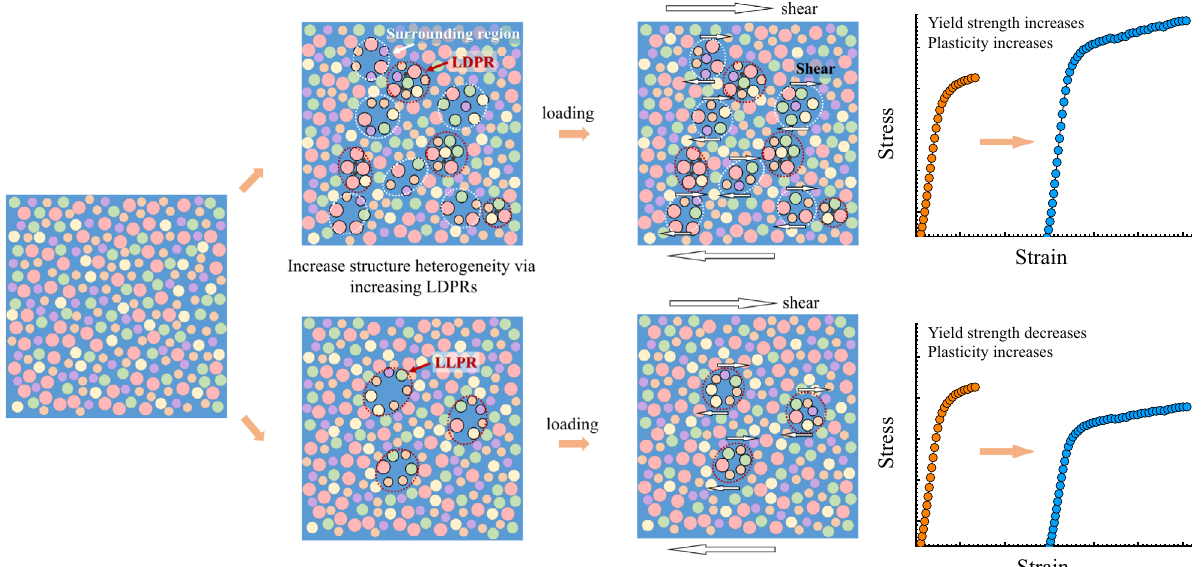
Fig. 6 Schematic illustration of two ways to enhance structural heterogeneity of BMGs. One is to increase LLPRs by pre-deformation etc., through which plasticity increases, but at a loss of strength. The other way is to increase LDPRs by doping with NMEs, through which both strength and plasticity are enhanced. Spheres with varied colors and sizes represent different constituents of a multicomponent BMG